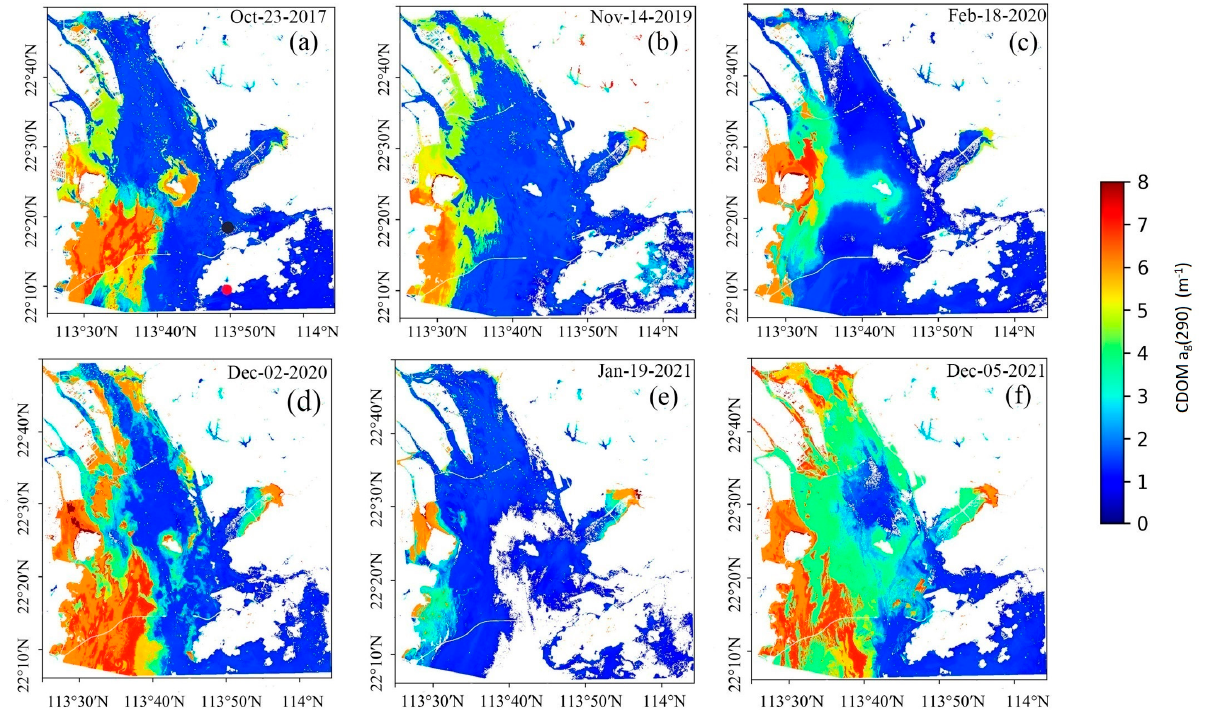
Figure 6. CDOM a g (290) derived from Landsat-8 the OLI data based on the XGBoost algorithm on